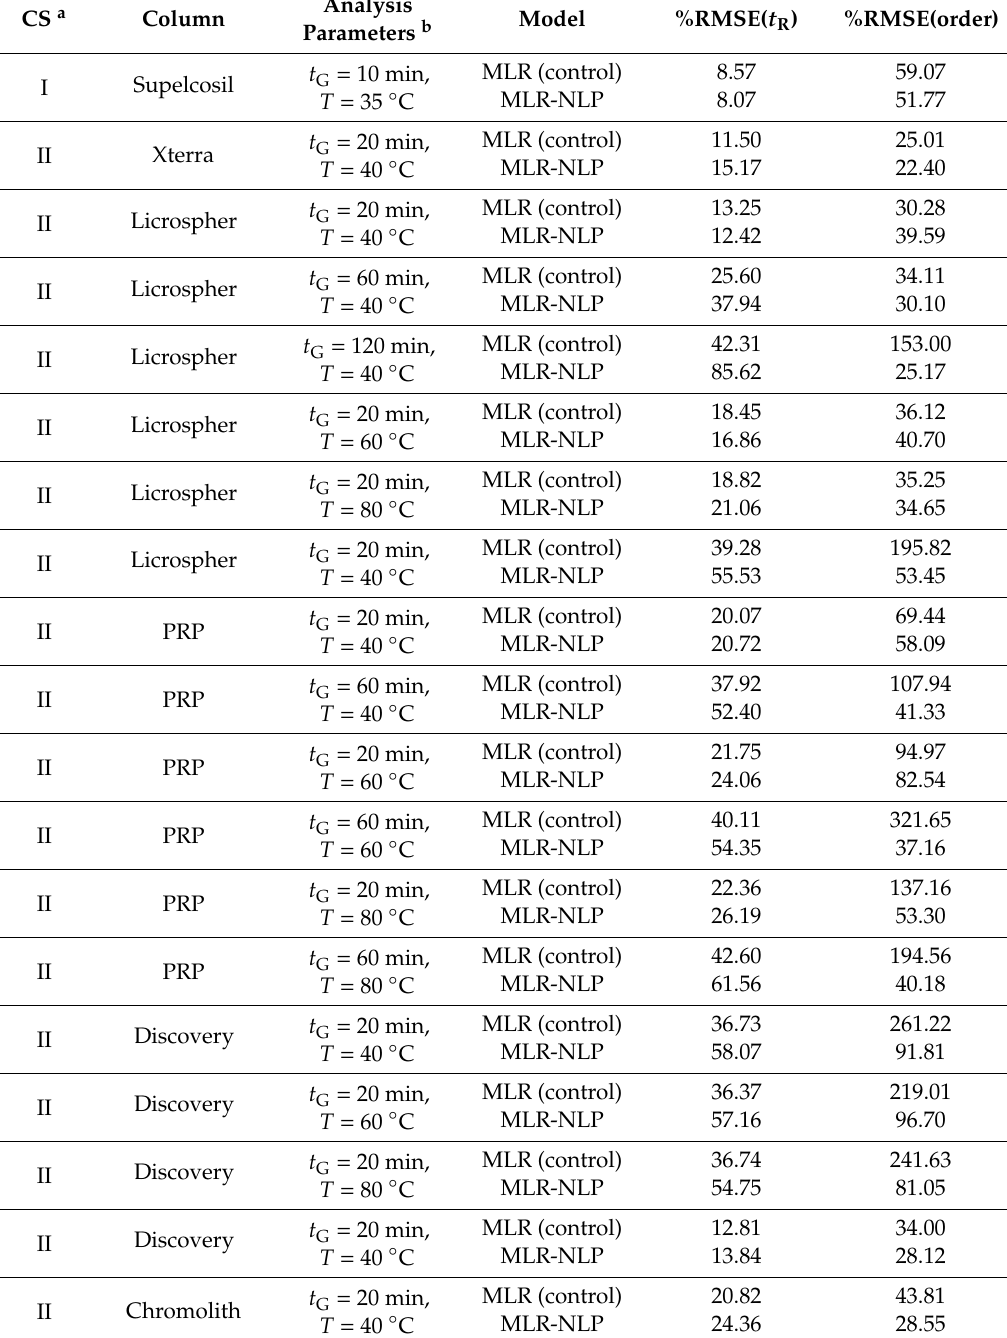
Table 2. Summary of model performances for the first and second case